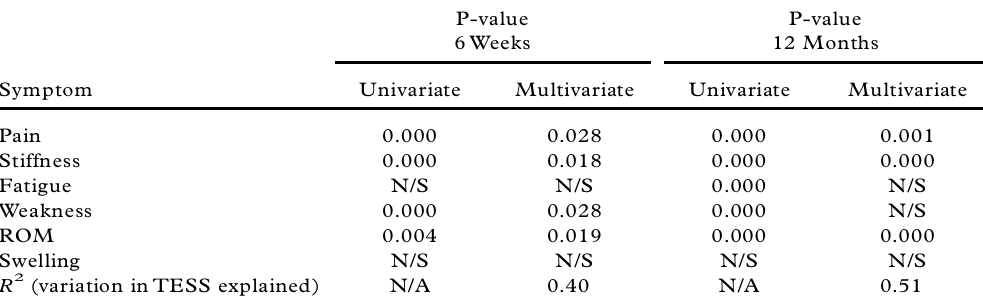
Table 2. Symptoms as a predictor of physical disability as measured by the TESS